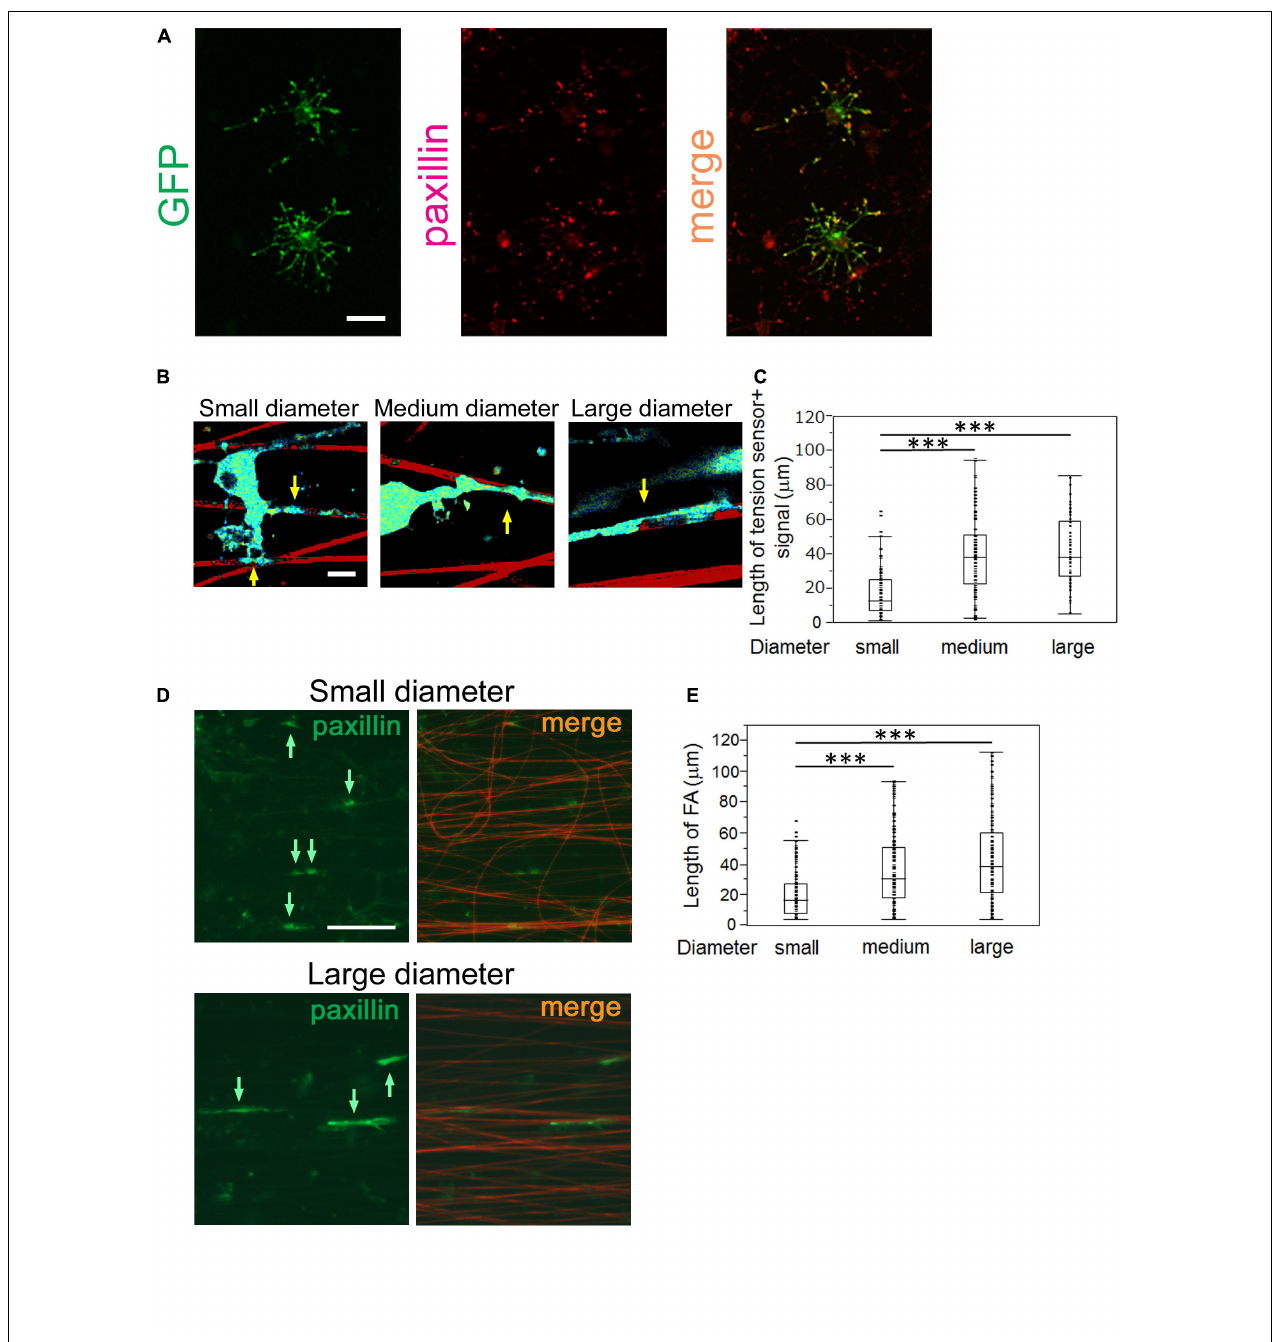
FIGURE 4 | OLs form longer FAs on larger diameter fibers and shorter FAs on smaller diameter fibers. (A) Double immunofluorescence of GFP + tension sensor (green) and paxillin (red), a typical FA marker, is shown. The GFP + tension sensor was co-localized with paxillin at the tip of OL processes. Scale bar, 20 µ m. (B) A representative length image of the tension sensor + signals on small, medium and large- diameter fibers. The longer signals were observed on larger diameter fibers. Sulforhodamine (red) shows polystyrene nanofibers. Arrows indicate the tension sensor + signals on nanofibers. Scale bar, 10 µ m. (C) The length of the tension sensor + signals was quantified in each fiber group. OLs formed shorter tension sensor + signals on small-diameter fibers (0.55–0.9 µ m), compared with those produced on medium (1.5–1.7 µ m) and large-diameter (2.5–4.0 µ m) fibers ( ∗∗∗ P < 0.001 by one-way ANOVA with a Tukey’s post hoc test; n = 81 areas analyzed per condition, from five independently prepared cultures established on different days). (D) Immunofluorescence of paxillin (an FA marker, green) is shown. Sulforhodamine (red) shows polystyrene nanofibers. The paxillin + FAs were observed on nanofibers with small or large diameters. Arrows indicate paxillin + FAs on nanofibers. Scale bar, 100 µ m. (E) The size of paxillin + FAs on each fiber group was quantified. The shorter FAs were formed on small-diameter fibers (0.55–0.9 µ m), whereas longer FAs were produced on medium (1.5–1.7 µ m) and large-diameter fibers (2.5–4.0 µ m) ( ∗∗∗ P < 0.001 by one-way ANOVA with a Tukey’s post hoc test; n = 96 FAs analyzed per condition, from three independently prepared cultures established on different days).